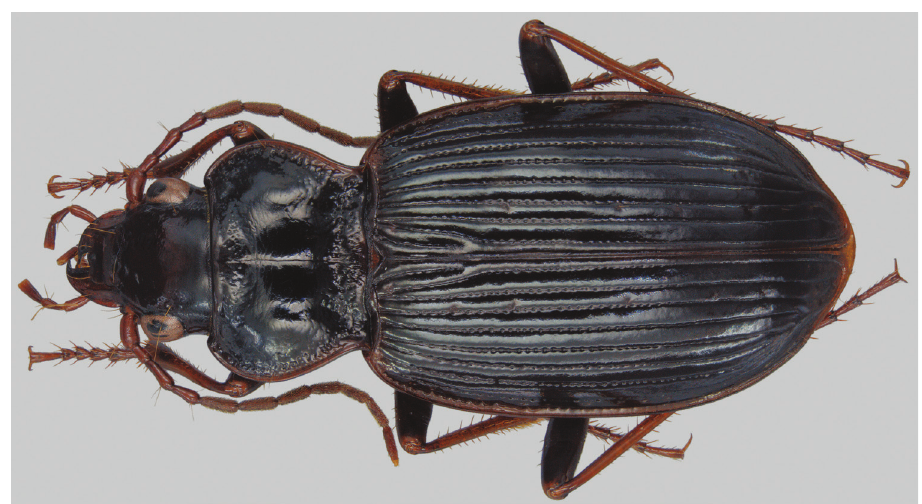
Figure 3. Dorsal habitus of Nebria brevicollis